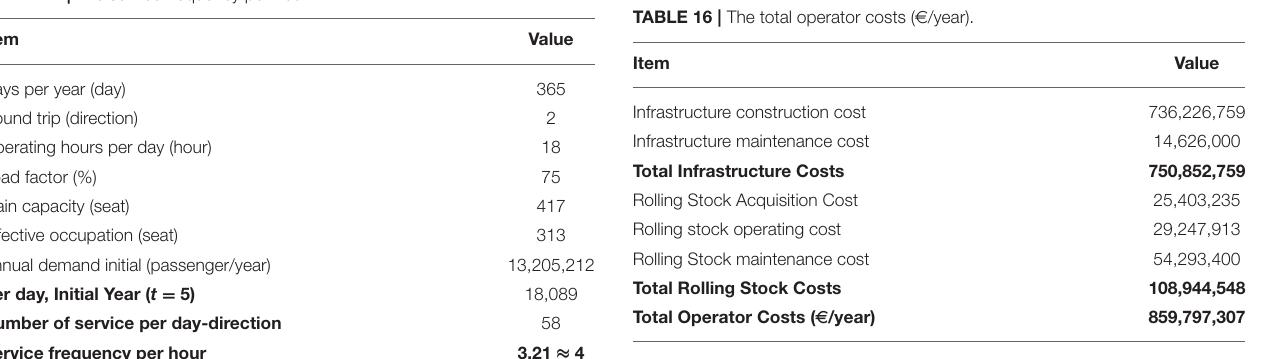
TABLE 12 | The service frequency per hour.